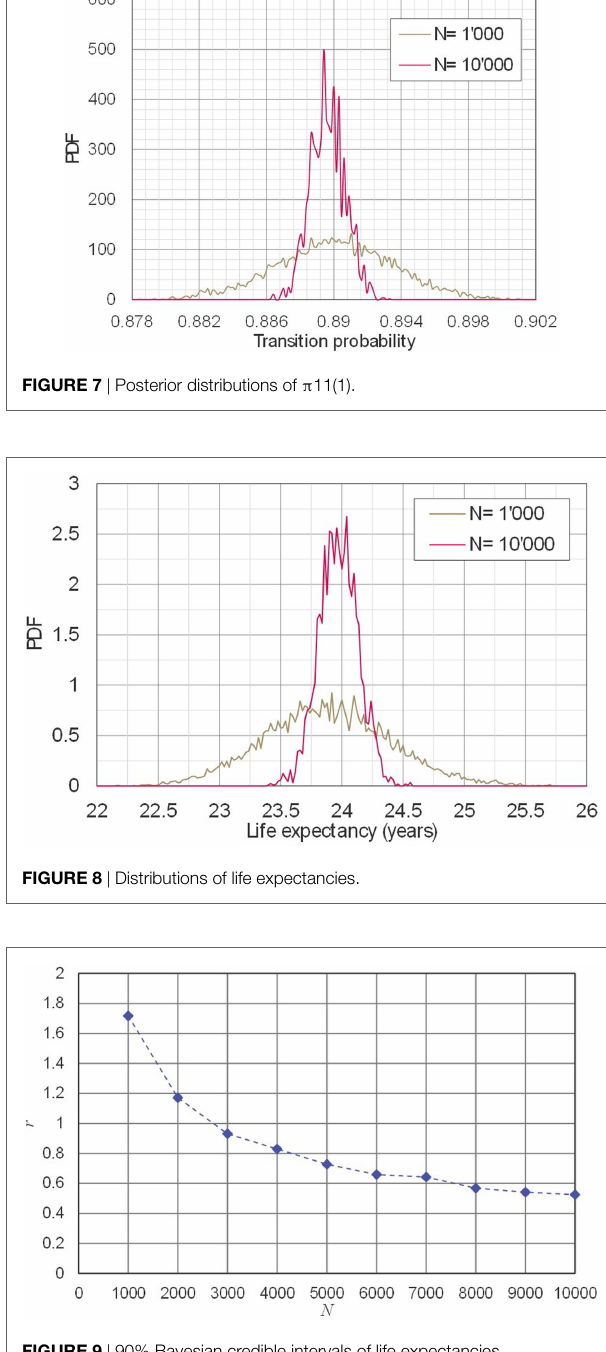
or more when R = 0.8 (years), and 8,000 or more when R = 0.6 (years),